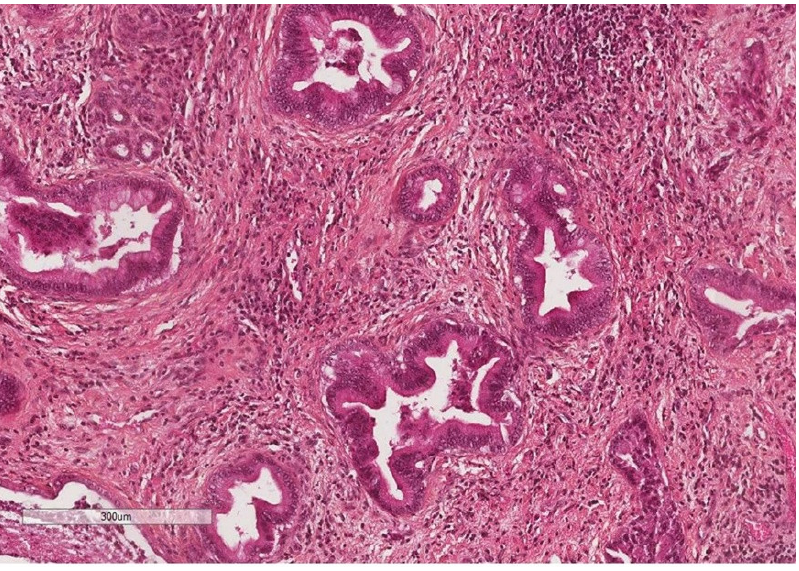
Figure 4. Large duct intrahepatic cholangiocarcinoma (HES staining ×250). Despite displaying shared mutations in KRAS, SMAD4, ARID1a and GNAS, these two subtypes present distinct clinicopathologic characteristics and molecular